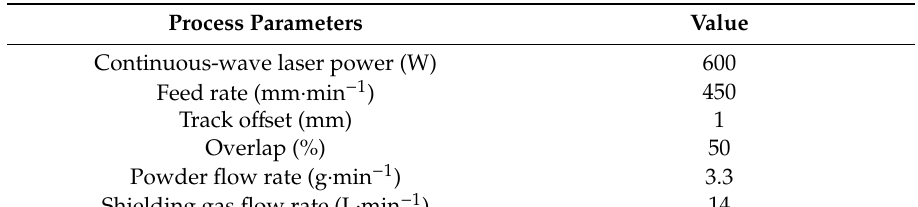
Table 2. Process parameters employed for the deposition of AISI H13.